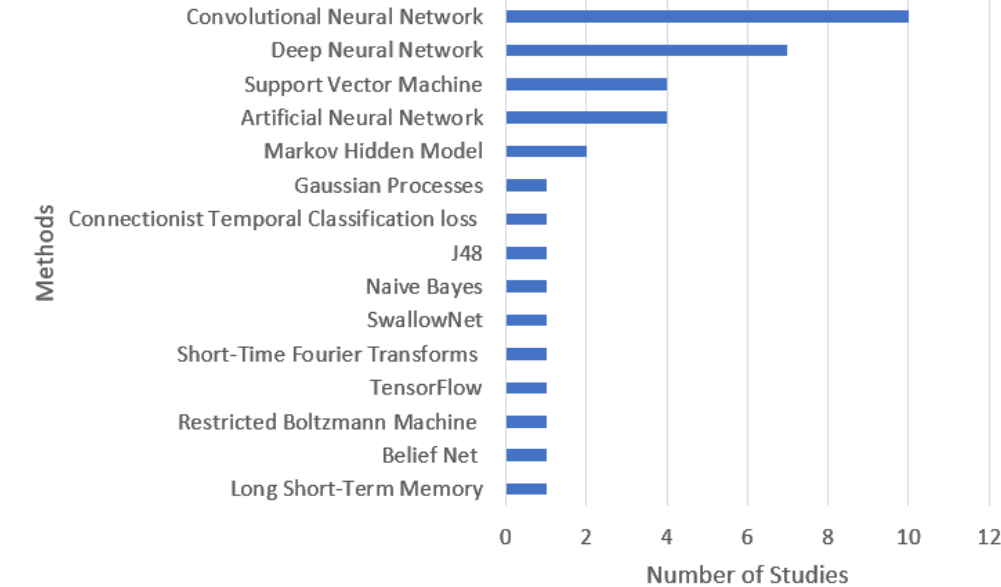
Figure 3. The relation between methodology and the number of studies.